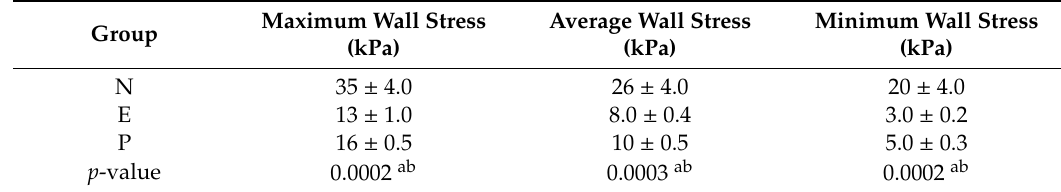
Table 3. Wall stress (mean ± SEM) computed in the mid-section of the FEA geometries corresponding to the three Ogden material